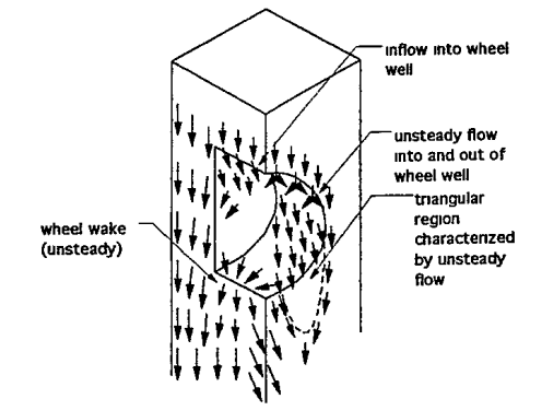
Figure 4. Surface oil flow visualisation by Fabijanic